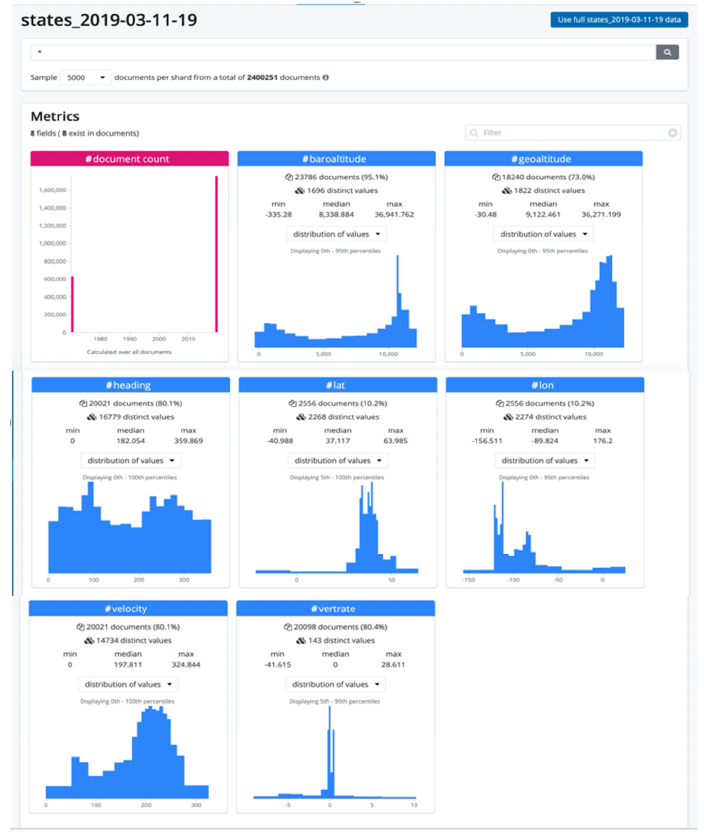
Figure 3. Elastic Kibana Visualizations of Statistics of OpenSky ADS-B Traffic.